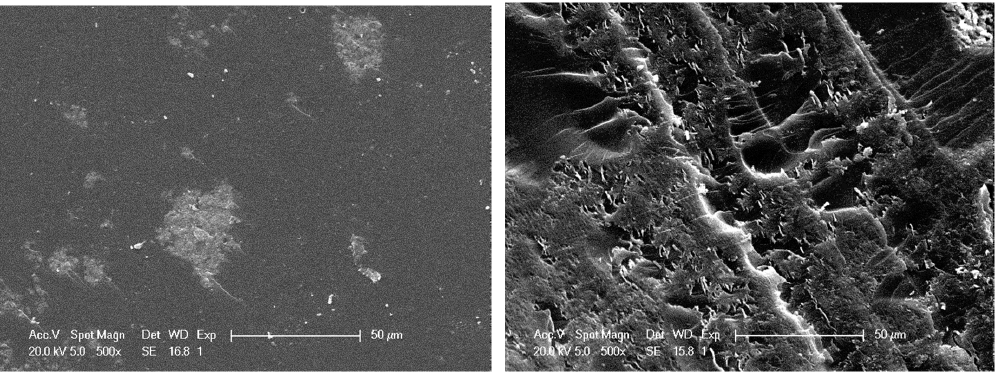
Figure 12. SEM analysis on fractured surfaces of DGEBA / DDS / MWNT nanocomposites (0.7 wt %) with a poor dispersion state, DD = 4.9 ( left ), and with a good dispersion state, DD = 74.5 ( right ). In order to go further into the investigations of fracture mechanisms, TEM micrographs were realized on crack ends for the different materials (Figure 13).